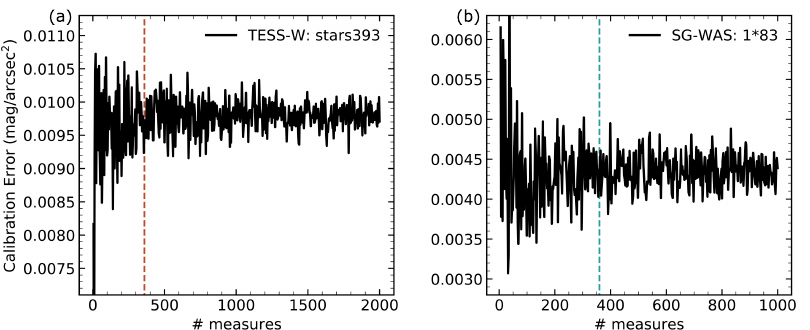
Figure 7. Calibration error obtained with the SIS method for a TESS-W photometer ( a ) and an SG-WAS ( b ), as a function of the number of measurements taken randomly. It is considered that the lower limit is reached from 360 onward (dashed vertical lines), corresponding to 6 and 30 h of night sky measurements, respectively.